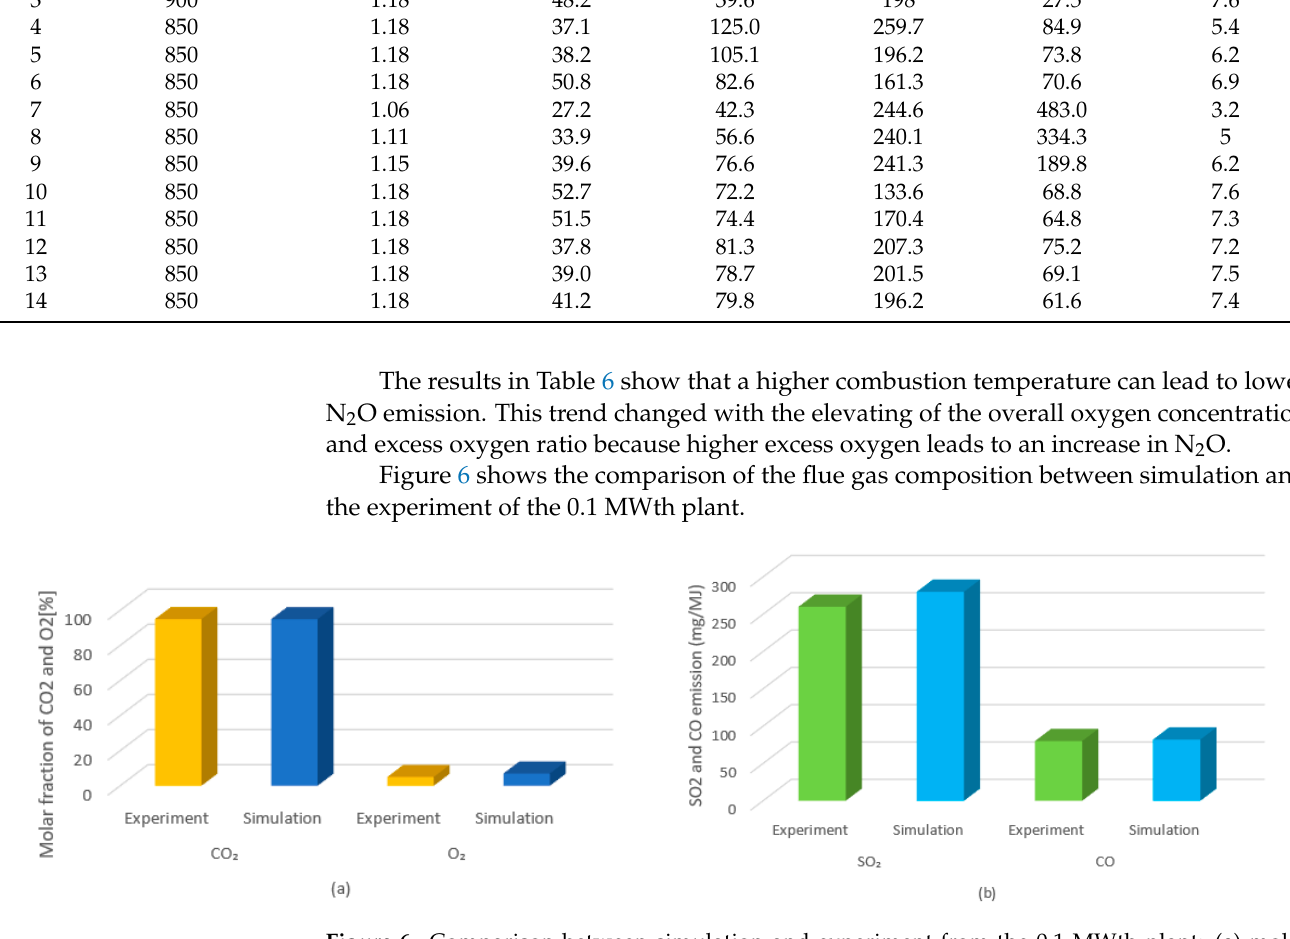
Figure 6. Comparison between simulation and experiment from the 0.1 MWth plant: ( a ) molar fraction of CO 2 and O 2 [%]; ( b ) SO 2 and CO emission [mg/MJ].